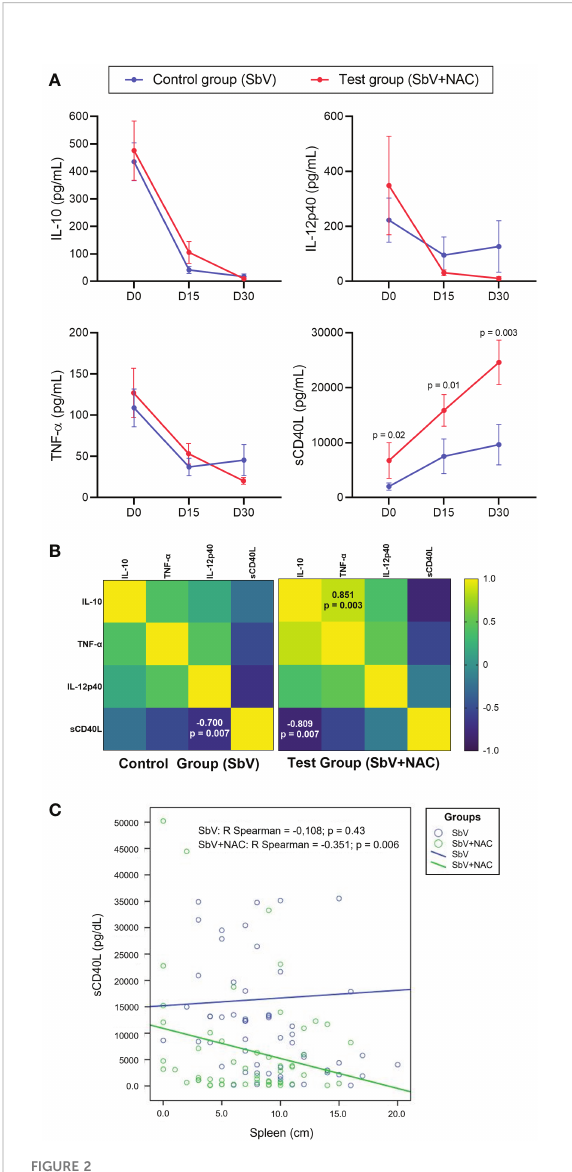
FIGURE 2 Immunological markersquanti fi ed in seraof patients included in pilot clinical trial study.Data areobtained before(D0),during(D15), and aftertreatment (D30)of the controlgroup (patients treated onlywith meglumine antimoniate for 28days; SbV, blue)and the test group (patients treated with meglumine antimoniate plus NAC for 20days; SbV + NAC, red). (A) Dots and their lines represent mean ± SEM of patients in the group (n= 14for SbVand n = 10for NAC). Kruskal – Wallis test followed by Dunn ’ s test was used for comparisons comparisonbetween groups. (B) Correlation among levels of cytokines measured during treatment (D15) inpatients of different groups was made using the Spearman correlation test. (C) For correlation between the sCD40L levels and the spleen size, data are resampled using bootstrapping.Dotsrepresent resampled data, and lines represent